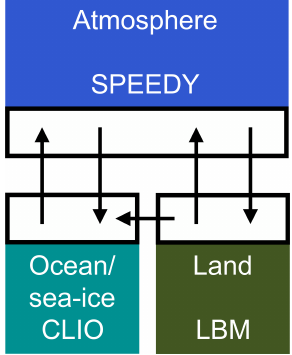
Figure 1. Schematic representation of the SPEEDO climate model. The atmosphere needs surface characteristics (temperature, rough- ness, reflectivity, soil moisture) in order to calculate the exchange of heat, water and momentum. Coupler software communicates this information between the components and interpolates between the computational